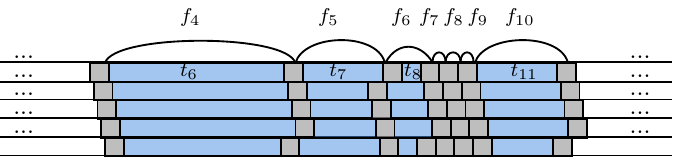
Figure 1. The h -shifted block parsings for h = 0,1,2,3,4. Gray and blue rectangles denote, respec- tively, phrases d h , i and t h , i . Here, we have b = 5. Note that some phrases t h , i are empty and, thus, not